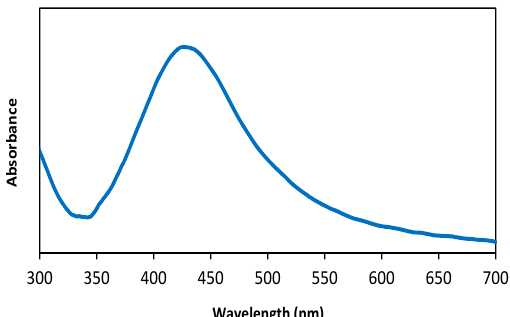
Fig. 5. UV-Vis spectrum of the green synthesized Ag NPs Fig. 5 UV-Vis spectrum of the green synthesized Ag NPs using Oenothera biennis extract using Oenothera biennis